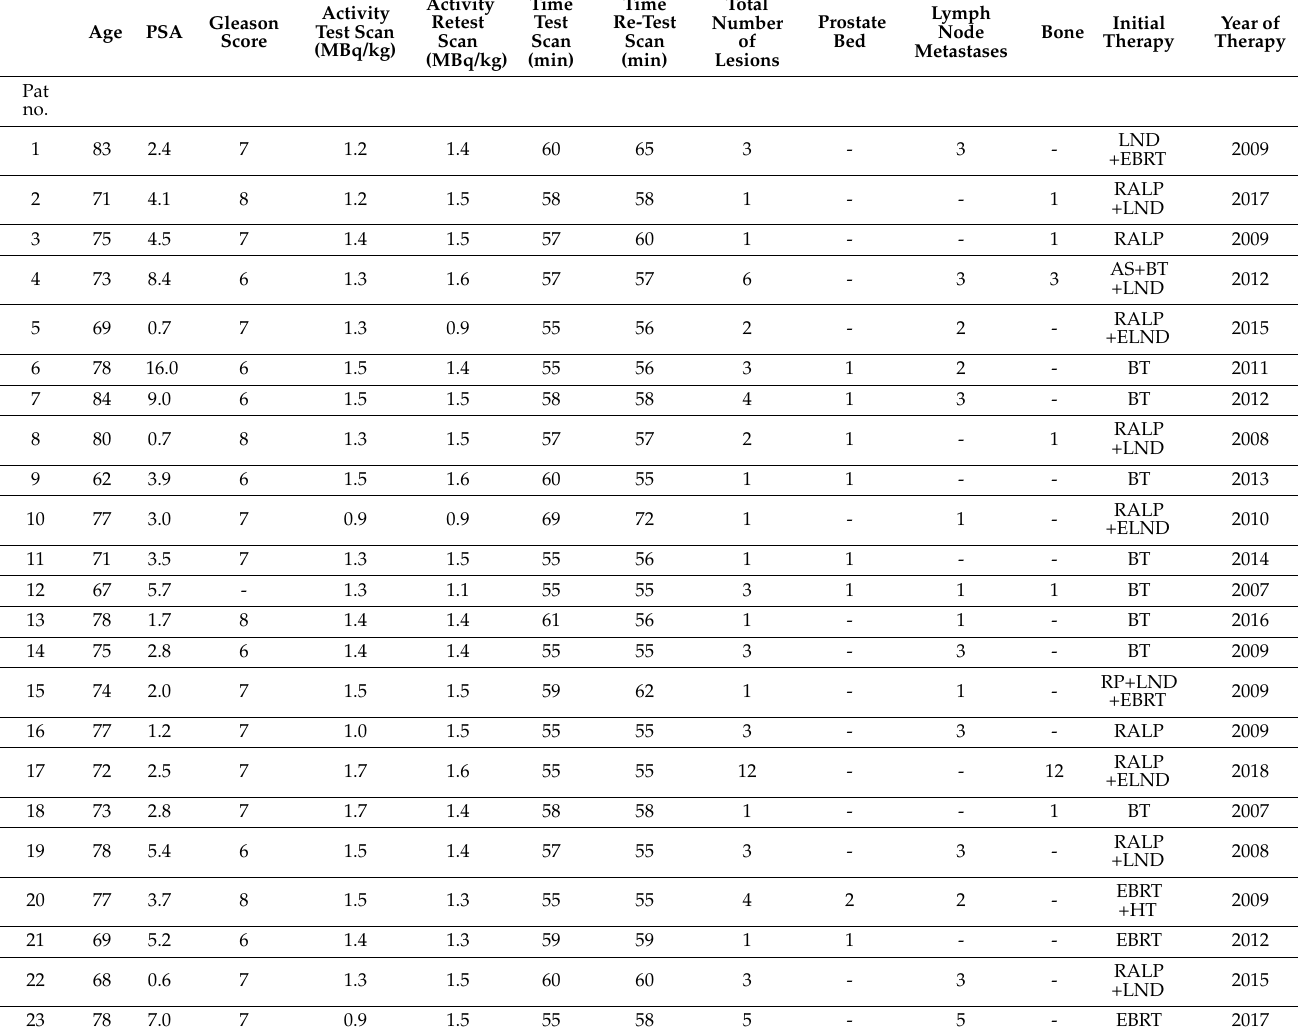
Table 1. Patient characteristics.